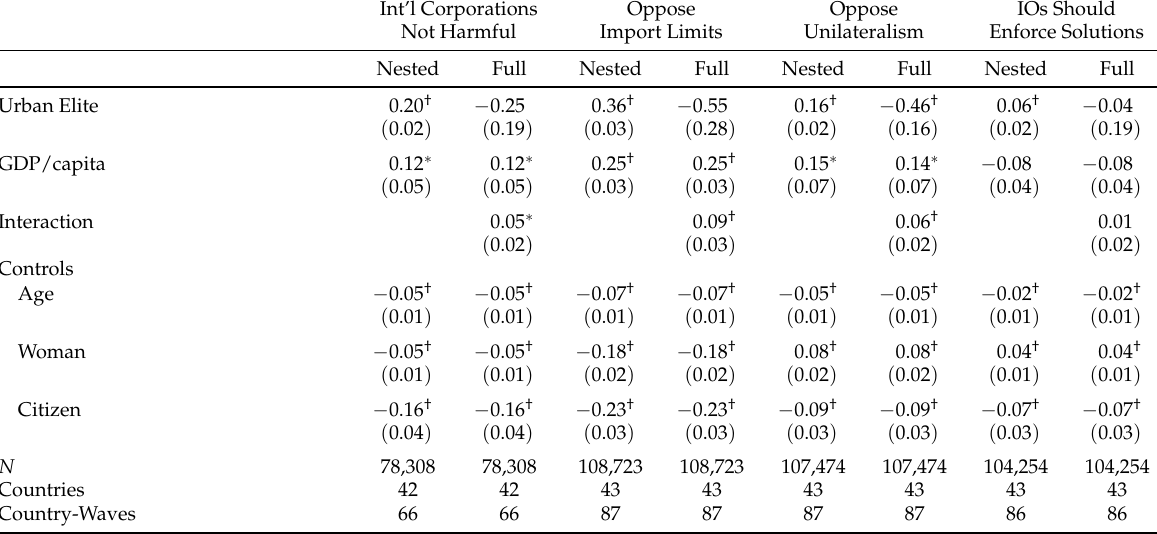
Table 1: Mixed-effects regression models on cooperative-internationalist attitudes (global